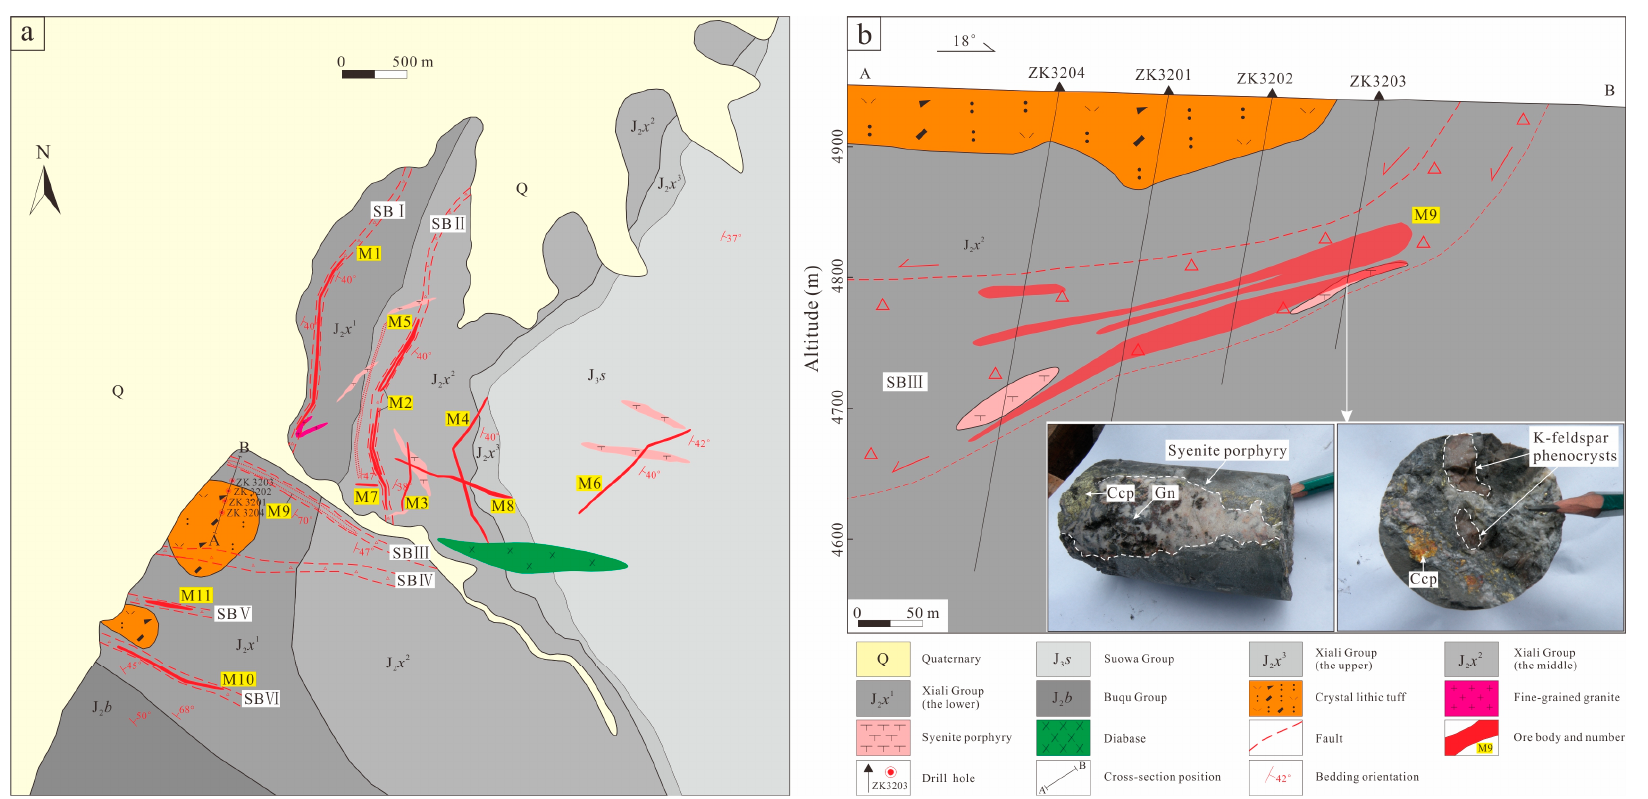
Figure 3. ( a ) Geological map of the Chuduoqu Pb-Zn-Cu deposit; ( b ) Geological cross-section of the M9 ore body.